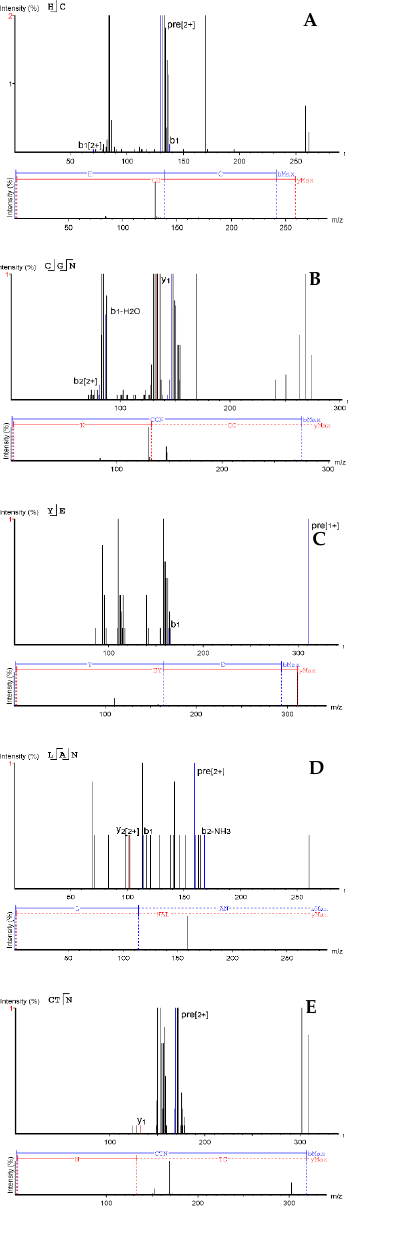
Figure 5. De-convoluted annotated MS/MS fragmentation spectra of peptides in fraction 1B and the corresponding de novo sequencing: HC ( A ), CGN ( B ), YE ( C ), LAN ( D ), CTN ( E ), LAF ( F ), MMGW ( G ), QFAAD ( H ), CSGD ( I ), and YT ( J ).